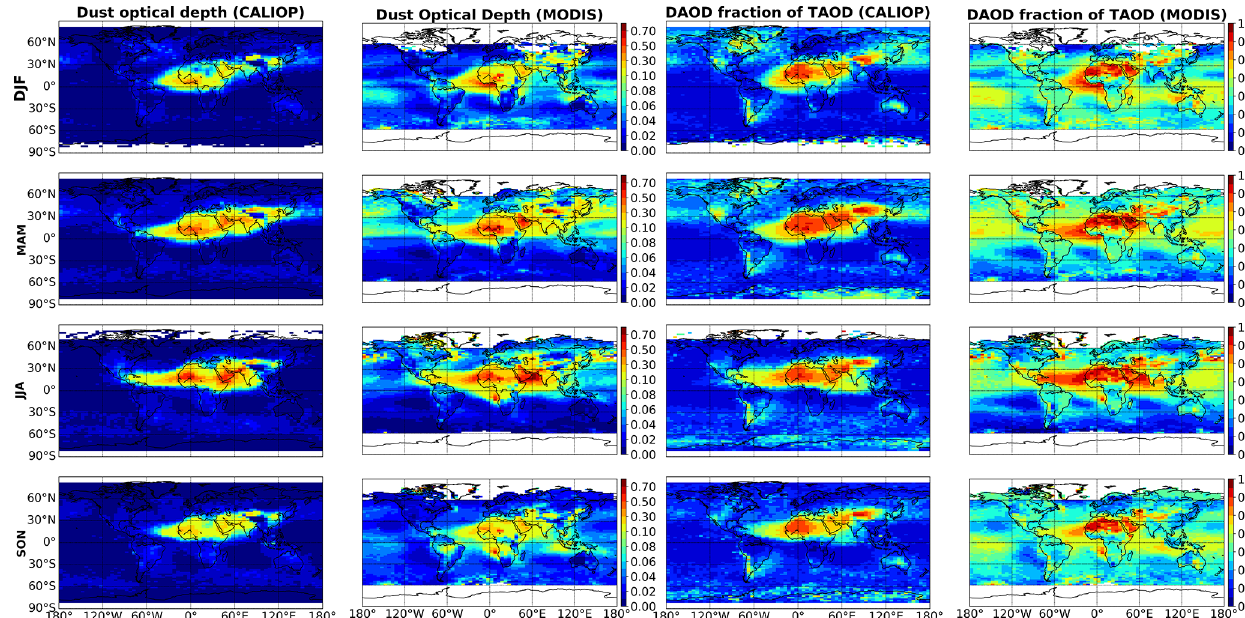
Figure 5. Spatial distribution of the seasonal mean CALIOP-based DAOD, MODIS-based DAOD, and the fraction of DAOD with respect to the TAOD based on CALIOP and MODIS, respectively, for the globe at a 5 ◦ longitude × 2 ◦ latitude resolution based on 13-year